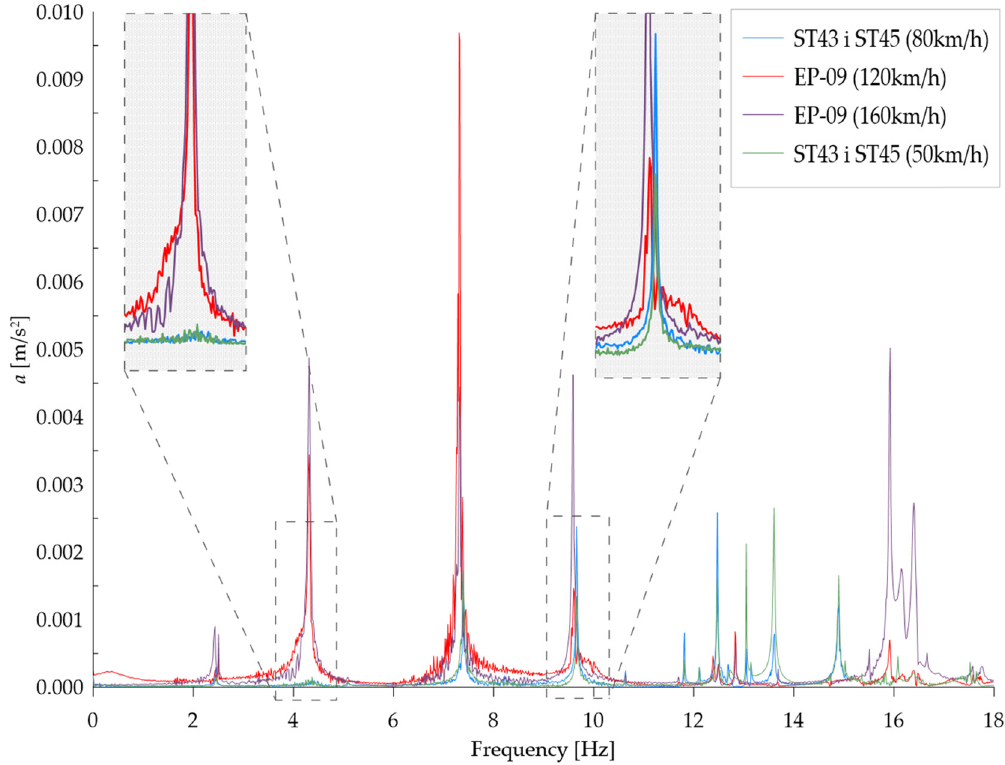
Figure 2: Signal analysis based on acceleration measurements – DFT analysis of the signal after the locomotive leaves the bridge for 0.5 L – in situ studies [ 20 ] t